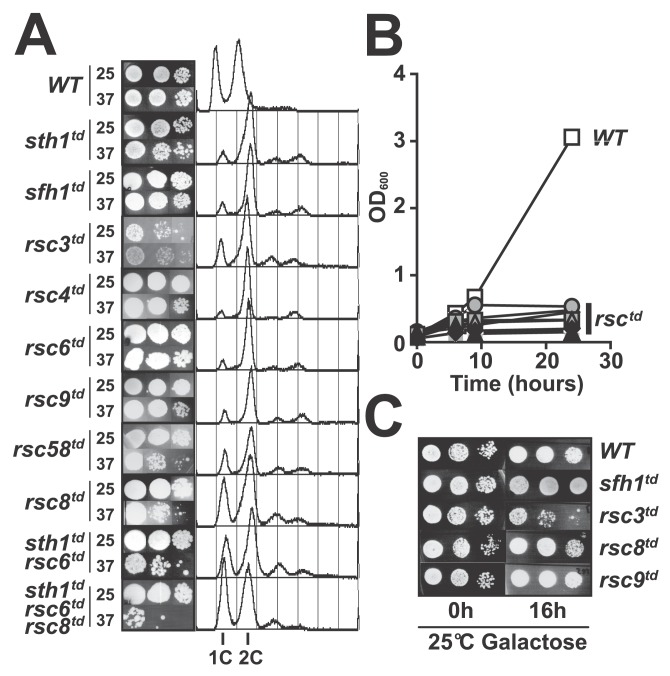
Conditional Depletion of RSC Subunits Terminally Arrests Cells at Multiple Stages of the Cell Cycle(A) Characterization of yeast strains bearing degron alleles of RSC subunits. Strains were cultured in galactose media at 25 °C (left panel, top lanes) or 37 °C (left panel, bottom lanes) to deplete degron fusions of RSC subunits for 3, 6, and 9 h (only 9 h shown), and a 10-fold serial dilution was spotted onto rich medium and incubated for 3 d at 25 °C (left panel; see Materials and Methods). In parallel, aliquots were taken following depletion and analyzed for DNA content by flow cytometry (right panel). For a more complete set of strains, see Figure S2.(B) Growth curves under nonpermissive conditions of several strains used in (A) □, Wild type; , sth1td;
 , sfh1td;⧫, rsc3td; •, rsc4td; █ , rsc6td; ▴ , rsc9td;▴ , rsc58td; ⧫, rsc8td.
(C) Cells were shifted from YEP-glucose medium supplemented with 0.1 mM CuSO4 at 25 °C to YEP-galactose supplemented with 0.1 mM CuSO4 at 25 °C, and 10-fold dilutions were spotted after 0 or 16 h onto glucose containing plates with 0.1 mM CuSO4 and incubated at 25 °C. All strains displayed in this figure contain the Pgal::UBR1 allele.